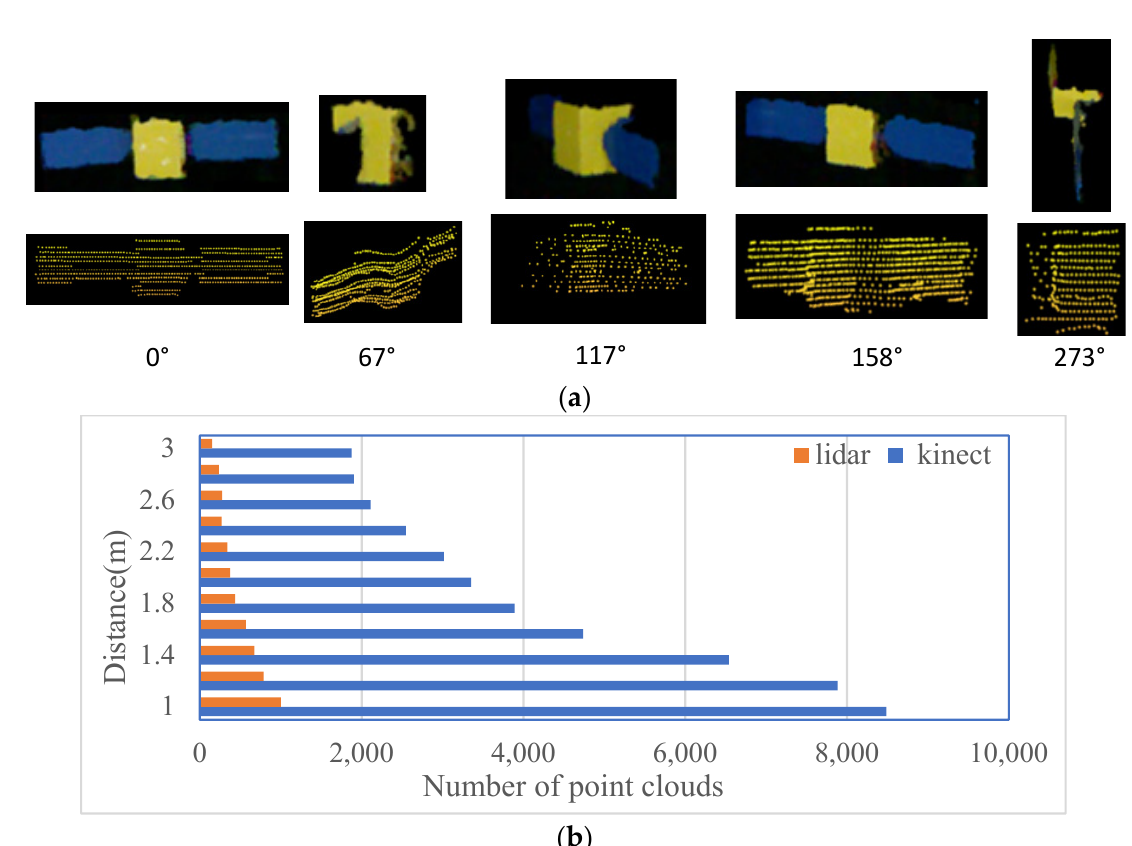
Figure 1. ( a ) Comparison of Kinect (upper) and LiDAR (lower) point clouds at different rotation angles. ( b ) Comparison of the numbers of frame point clouds with LiDAR and Kinect at different distances.